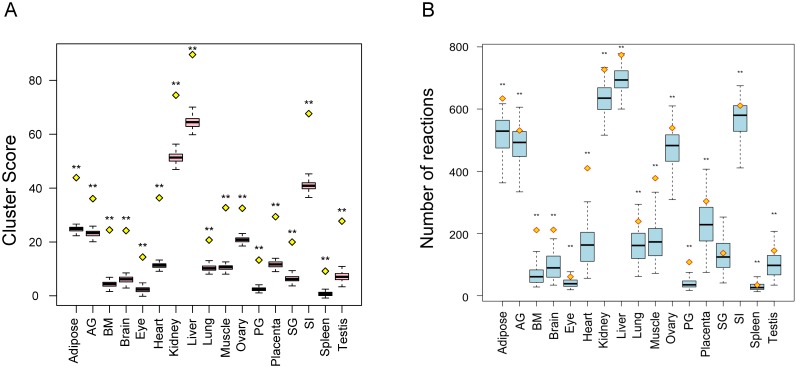
Evaluation of the statistical significance and the size of the largest connected local tissue-specific metabolism/transport clusters.(A) The yellow diamonds mark the scores of the largest connected clusters. The distribution of simulated scores of the same cluster is illustrated in the pink boxplot. (B) The yellow diamonds mark the sizes of the largest connected clusters. The sizes of the simulated largest connected clusters are illustrated in the form of a blue boxplot. AG, adrenal gland; BM, bone marrow; PG, pituitary gland; SG, salivary gland; SI, small intestine. ** represents p<0.001 in Student’s t-test.